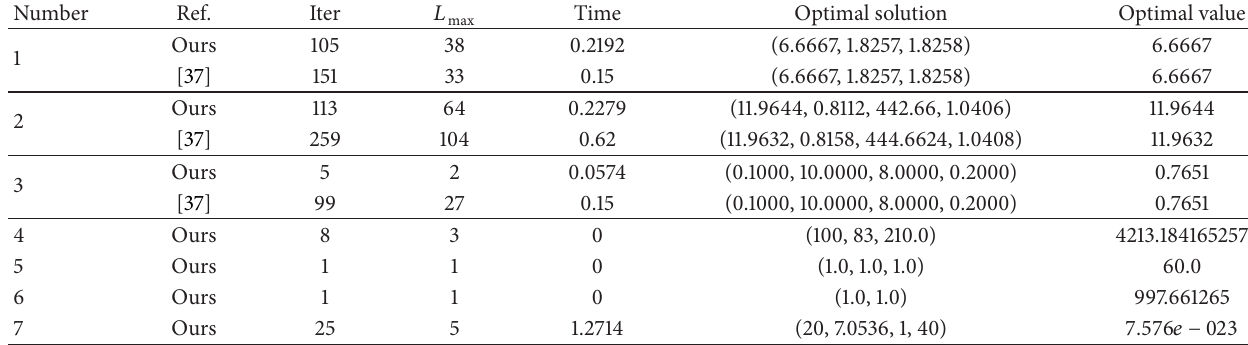
Table 4: 𝛼 = 0.35 ; the four strategies are all adopted in Section 3.